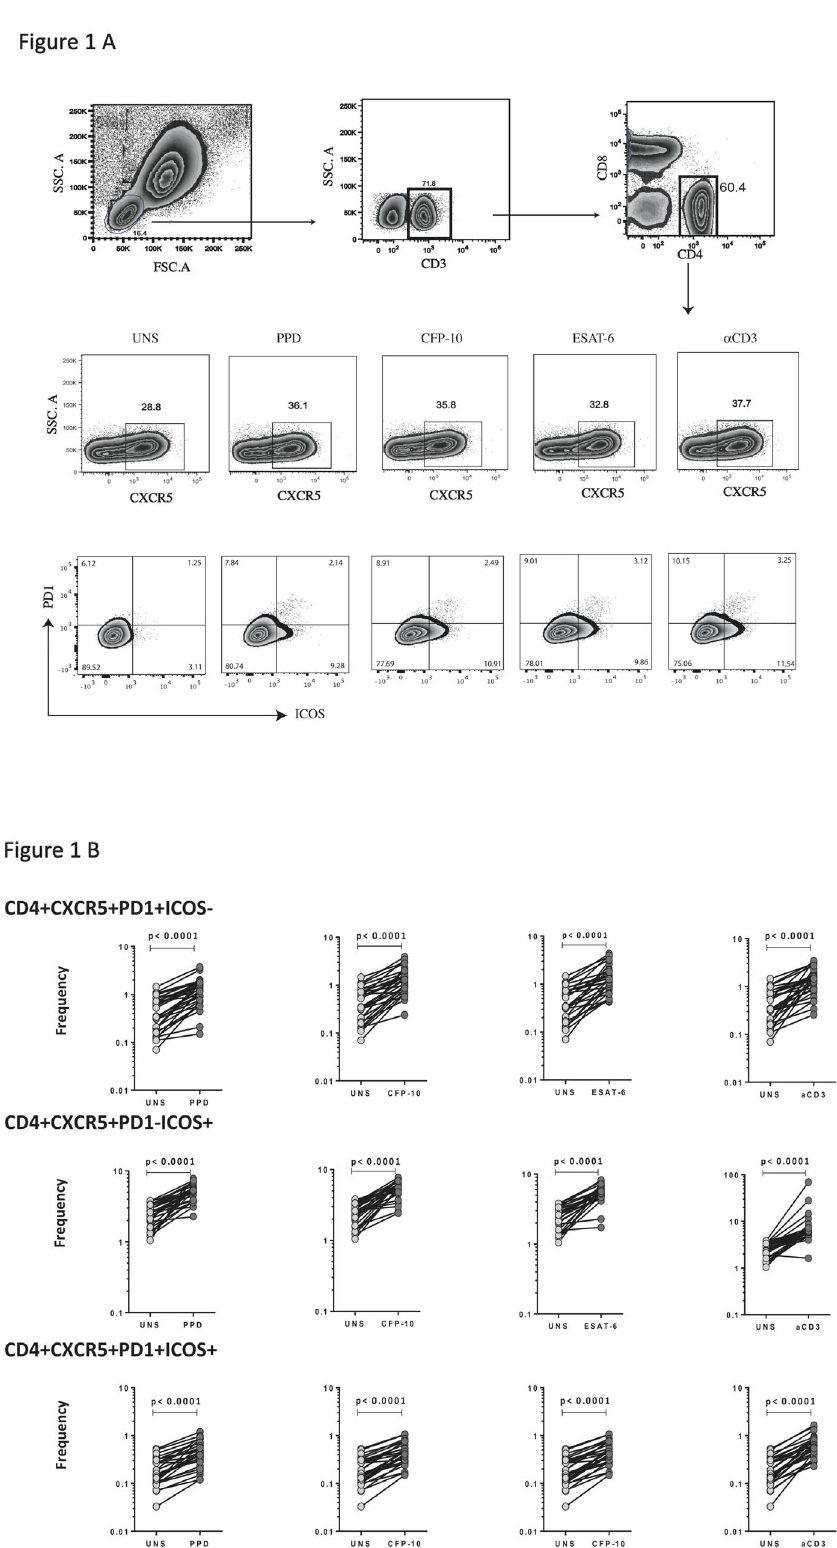
Figure 1. Expansion of Tfh cells subsets in response to TB antigens and anti-CD3 in PTB. Whole blood from PTB individuals was stimulated with media alone (UNS), PPD, CFP-10, ESAT-6 or anti-CD3 for 6 h (Gating strategy for Tfh cell subsets and representative plot shown in A) and (B) the frequencies of CD4 + CXCR5 + PD-1 + , ICOS 2 ; CD4 + CXCR5 + PD-1 2 ICOS + and CD4 + CXCR5 + PD-1 + ICOS + T cells were estimated by flow cytometry. Results are shown as line diagrams with each line representing a single individual. P values were calculated using the Wilcoxon signed rank test.